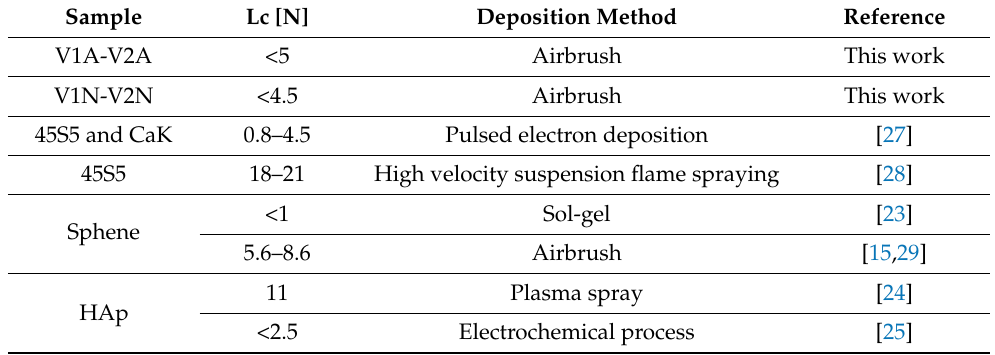
Table 2. Overview of critical load Lc for bioglasses and bioceramic coatings deposited on Ti substrates.